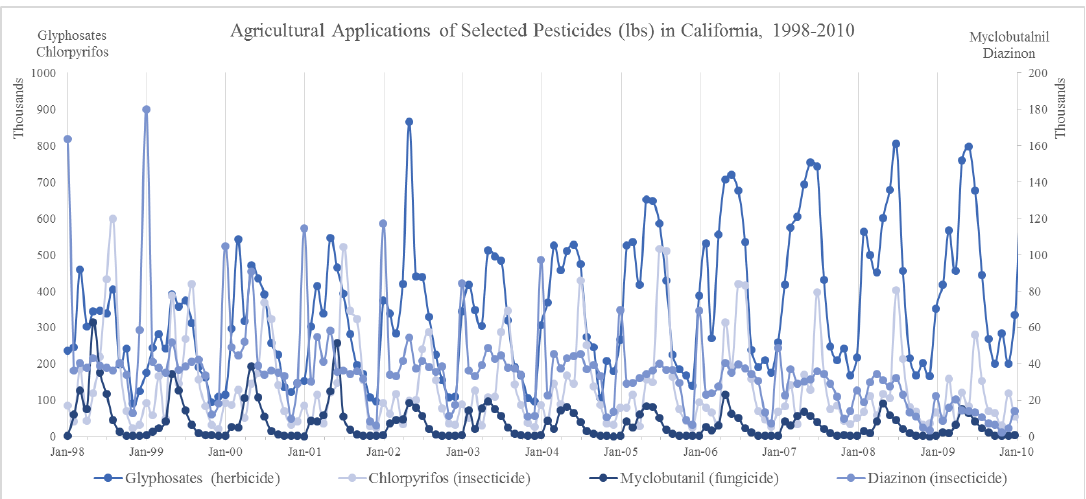
Figure 1. Seasonal variation of selected pesticide applications.